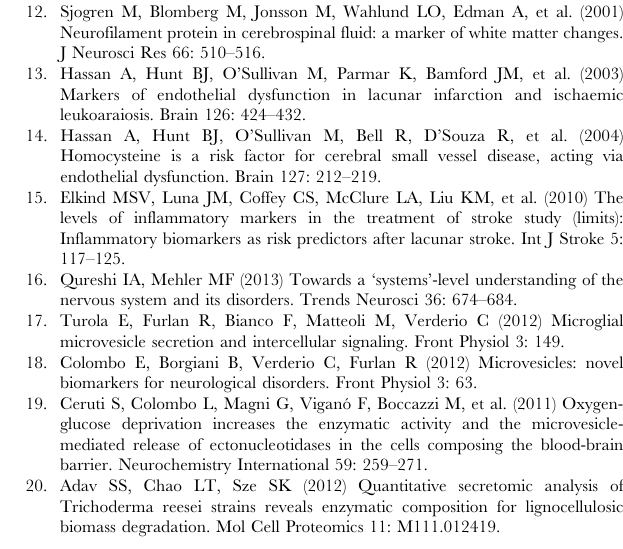
Table S1 Complete information of the full list of the qualified proteins obtained from the bias and back- ground corrected iTRAQ data set. Table S2 Full list of the identified peptides exported from the ProteinPilot software obtained following database